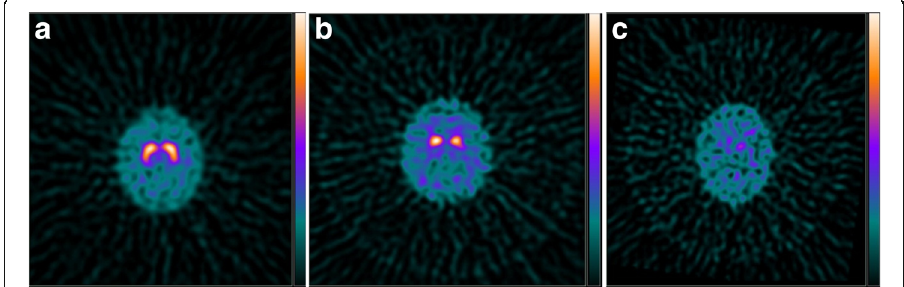
Fig. 1 DaT scan examples. DaT scan transaxial SPECT sections for: ( a ) a patient with essential tremor, showing high symmetric uptake in both caudate and putamen regions; ( b ) a patient with Parkinson ’ s disease, showing markedly reduced putamen activity and asymmetric caudate activity; ( c ) a patient